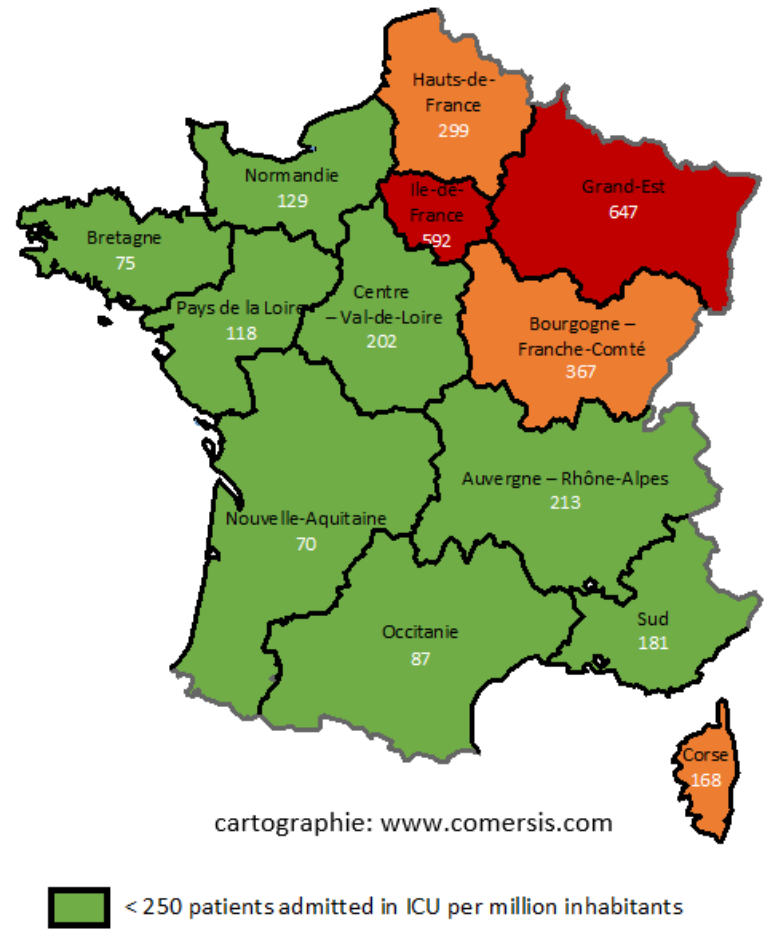
Figure 2. Regional distribution of COVID-19 mortality per million inhabitants. Green indicates regions that were less impacted by COVID-19, orange indicates regions that were moderately impacted by COVID-19 and red indicates regions that were strongly impacted by COVID-19. Map was obtained from